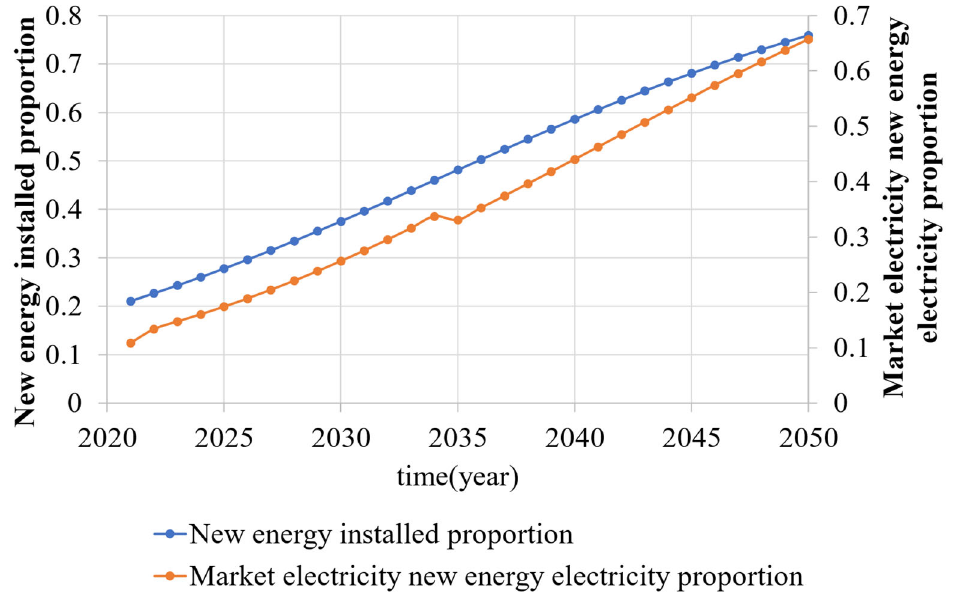
Figure 2. Simulation results of renewable energy power generation installed capacity share and renewable energy electricity share of market-based electricity under the basic scenario.